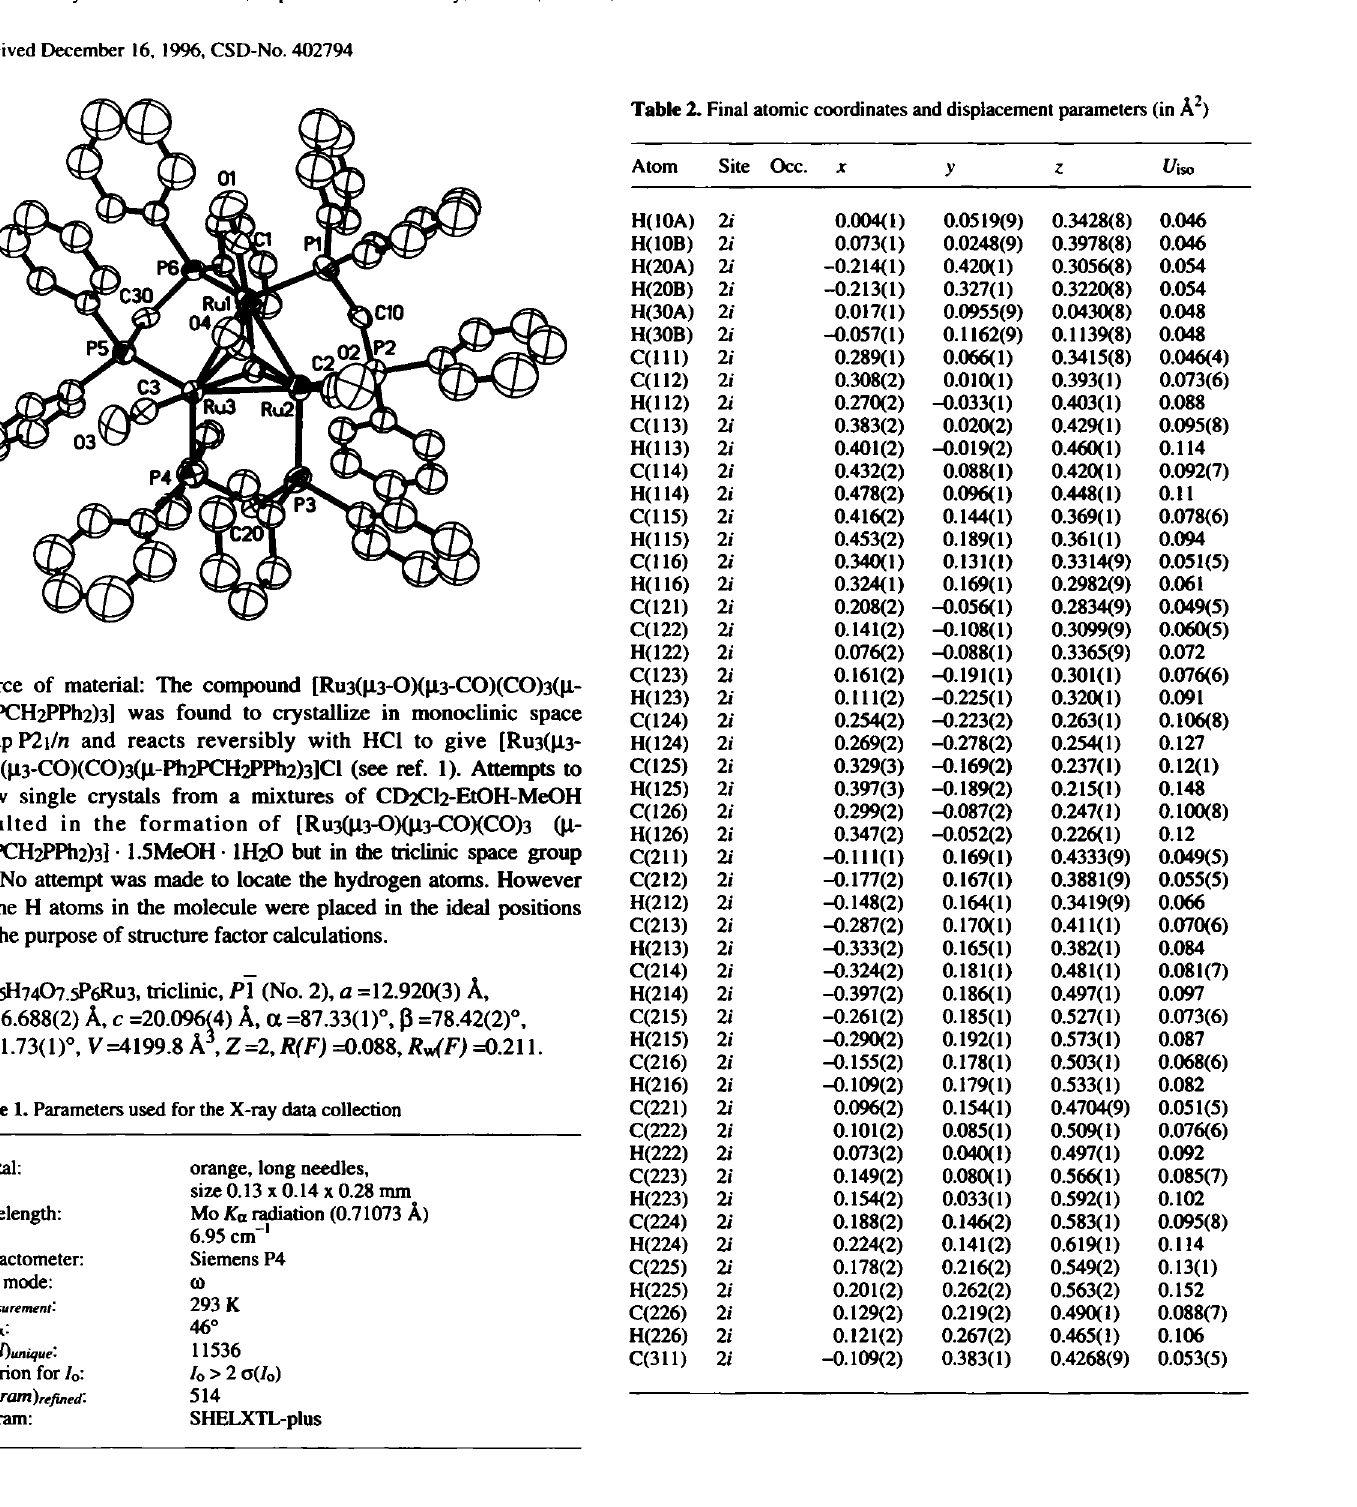
Table 2. Final atomic coordinates and displacement parameters (in A 2 )